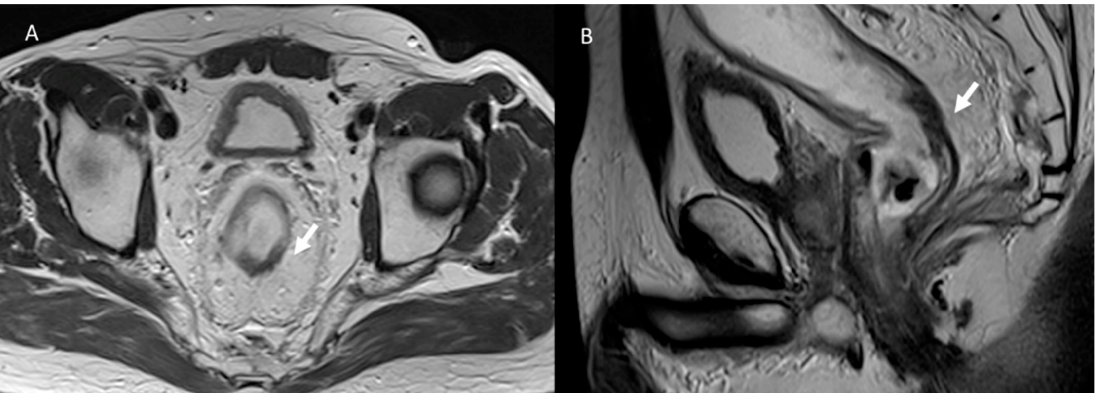
Figure 2. T2-W MRI assessment in post-treatment rectal cancer in the axial ( A ) and sagittal ( B ) plane. Arrows show fibrotic changes of the rectal wall without a residual lesion.